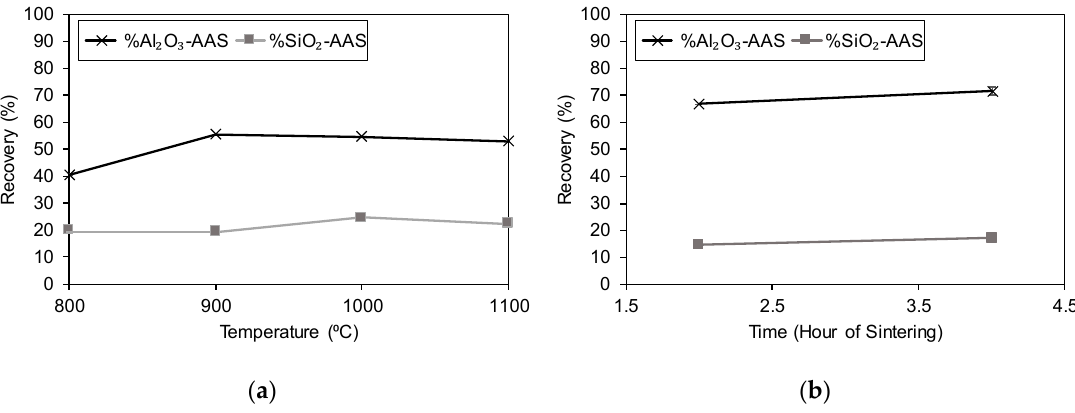
Figure 7. Recovery of Al 2 O 3 and SiO 2 for ( a ) temperature-variable sintering experiments with 5% stoichiometric excess of Na 2 CO 3 , and ( b ) time-variable with 50% stoichiometric excess of Na 2 CO 3 .